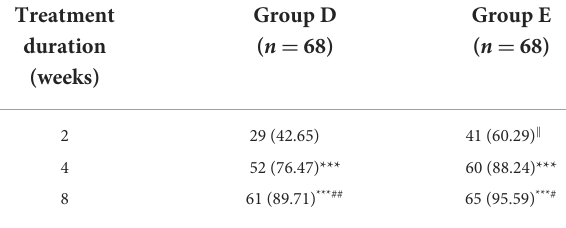
TABLE 5 The remission rate of overall gastrointestinal symptoms in patients with functional dyspepsia without mood disorders (n [%]).